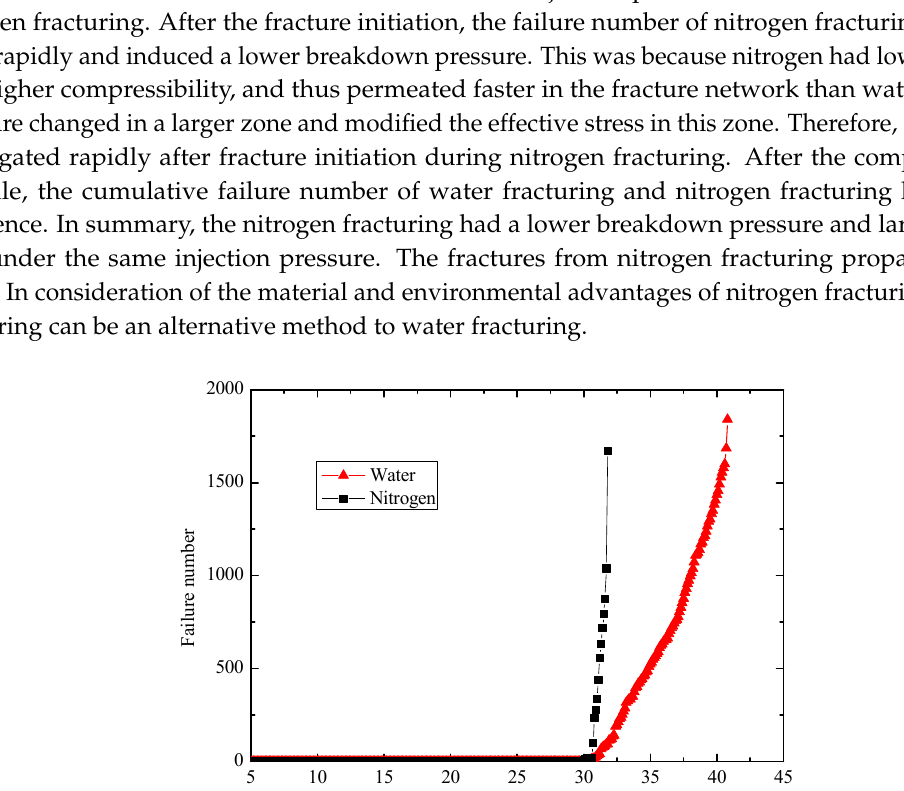
Figure 11. Fracture network evolution and related responses during the water and nitrogen fracturing processes.